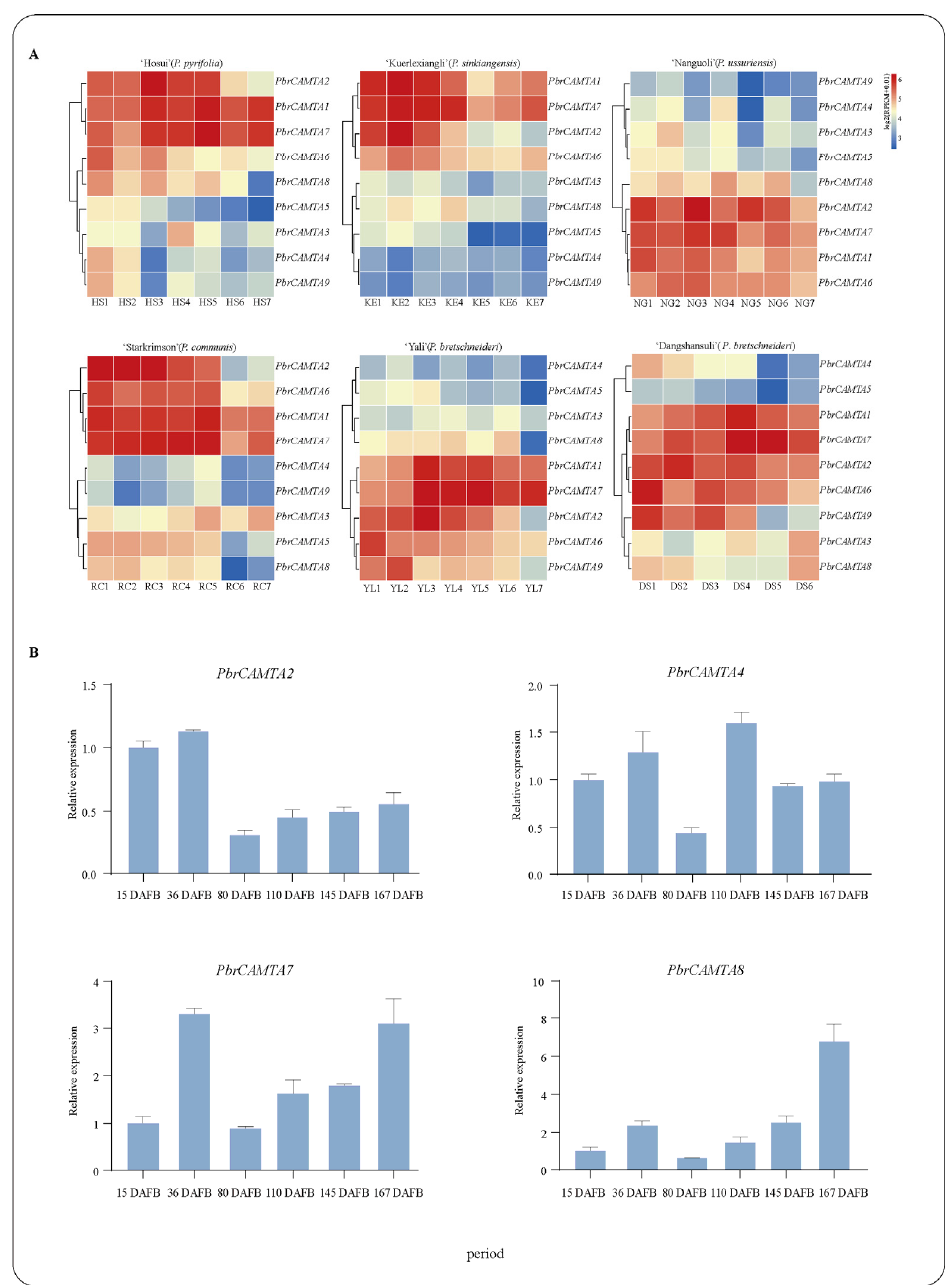
red indicates high expression, and blue indicates low expression. The color scale at the top right represents RPKM values normalized by log2. ( B ) qRT-PCR analysis of four PbrCAMTA genes in six different tissues. The x-axis represents six different tissues (stem, ovary, petal, sepal, fruit, and leaf), and the y-axis represents relative expression levels of the PbrCAMTA genes. Error bars indicate three technical replicates derived from one bulked biological replicate.